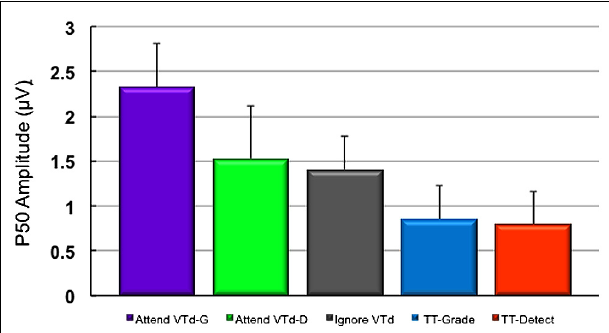
FIGURE 7 | (A) Group means ( n = 10) in Experiment 2 for P50 amplitudes measured at CP4 for the Grade and Detect tasks for both VTd andTT stimulation. P50 amplitude was maximal in the condition where participants graded their force to the crossmodal stimuli and the visual stimulus preceded the tactileTT stimulus by 100 ms (AttendVTd-G; purple bar). Purple and green bars represent group data for the crossmodal visual + tactile task conditions (VTd) in which subjects graded their force for the response (G) or indicated detection of the target stimulus (D).The gray bar represents the sameVTd condition during blocks where attention was directed to the unimodal (TT) stimuli (blue/red bars). Error bars show